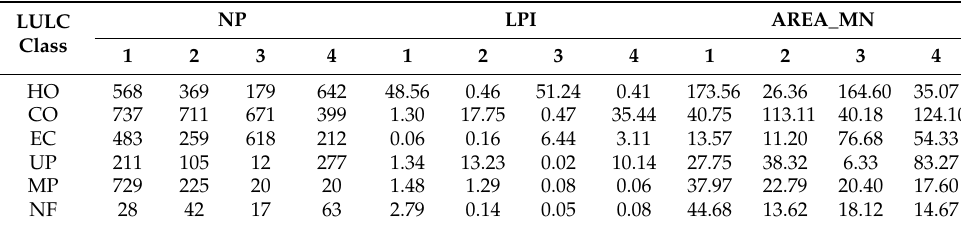
Table 8. Number of patches index (NP), largest patch index (LPI) and patch area (AREA_MN) per sub-region.